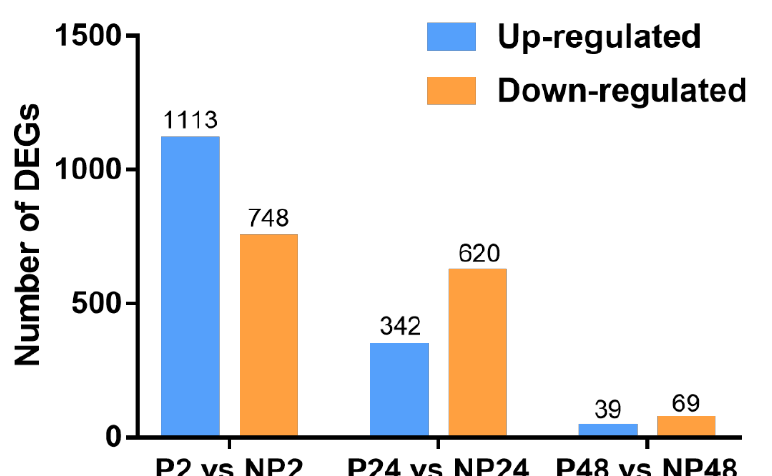
Figure 2. Identification of DEGs between the unparasitized and parasitized FAW larvae. Numbers of DEGs identified from the P2 vs. NP2, P24 vs. NP24, and P48 vs. NP48 groups. The upregulated and downregulated DEGs were presented in the blue and orange columns, respectively.